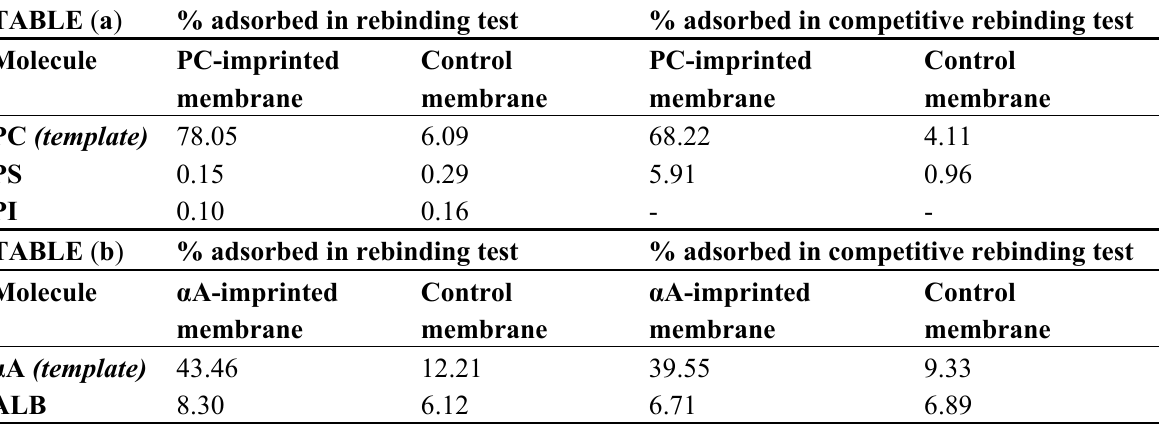
TABLE ( b ) % adsorbed in rebinding test % adsorbed in competitive rebinding test Molecule α